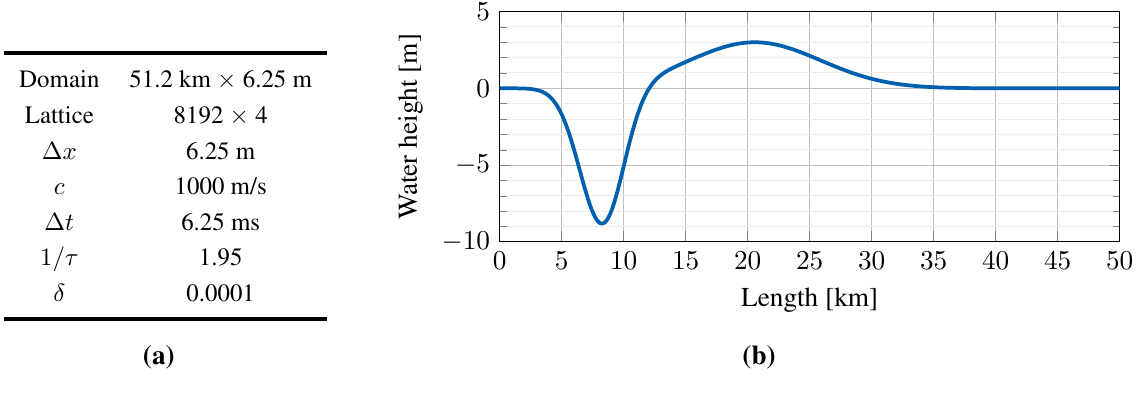
Figure 5. Initial wave profile. ( a ) Parameters; ( b ) tsunami runup onto a plane beach.